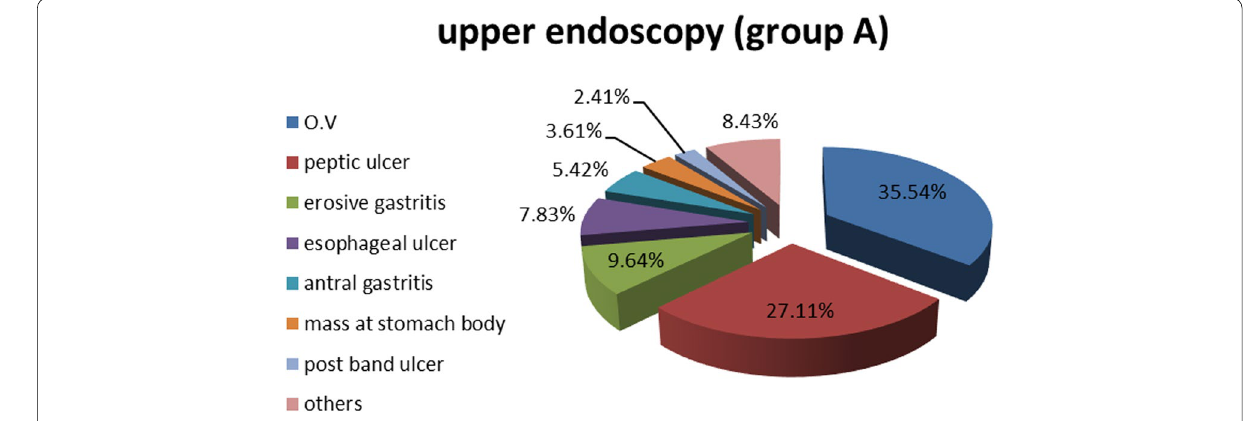
Fig. 3 Findings of upper endoscopy of elderly group